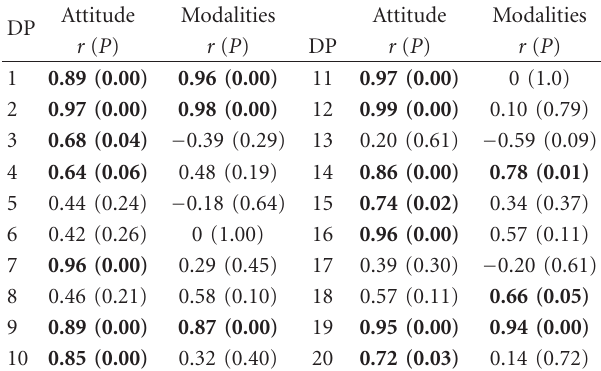
Table 7: Correlation test for each depth profile.